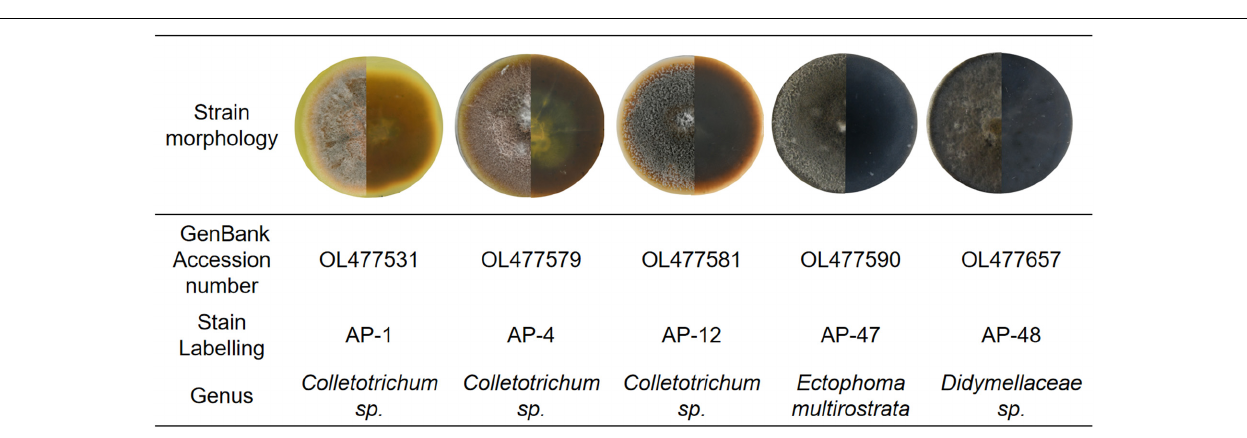
FIGURE 9 | The strain morphology, fermentation morphology, and mycelium morphology of AP-4 and AP-12.